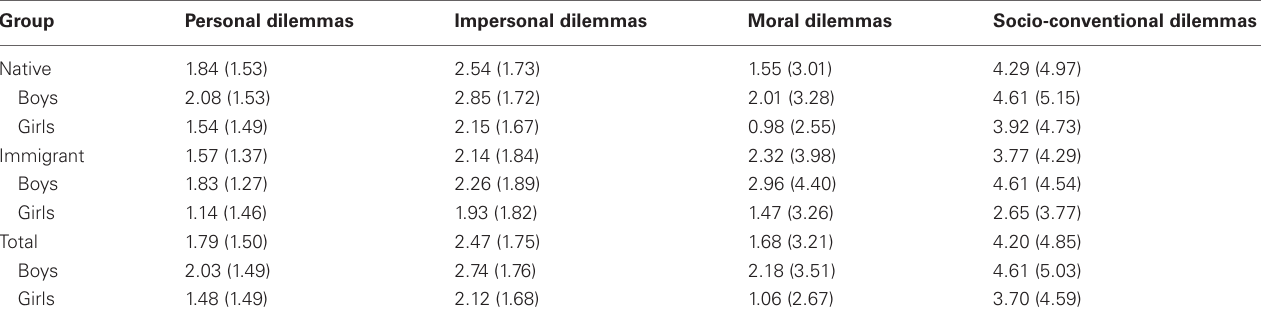
Table 4 | Mean scores (and standard deviations) of personal vs. impersonal dilemmas and moral vs. socio-conventional dilemmas in ANOVA including immigrant status as fixed